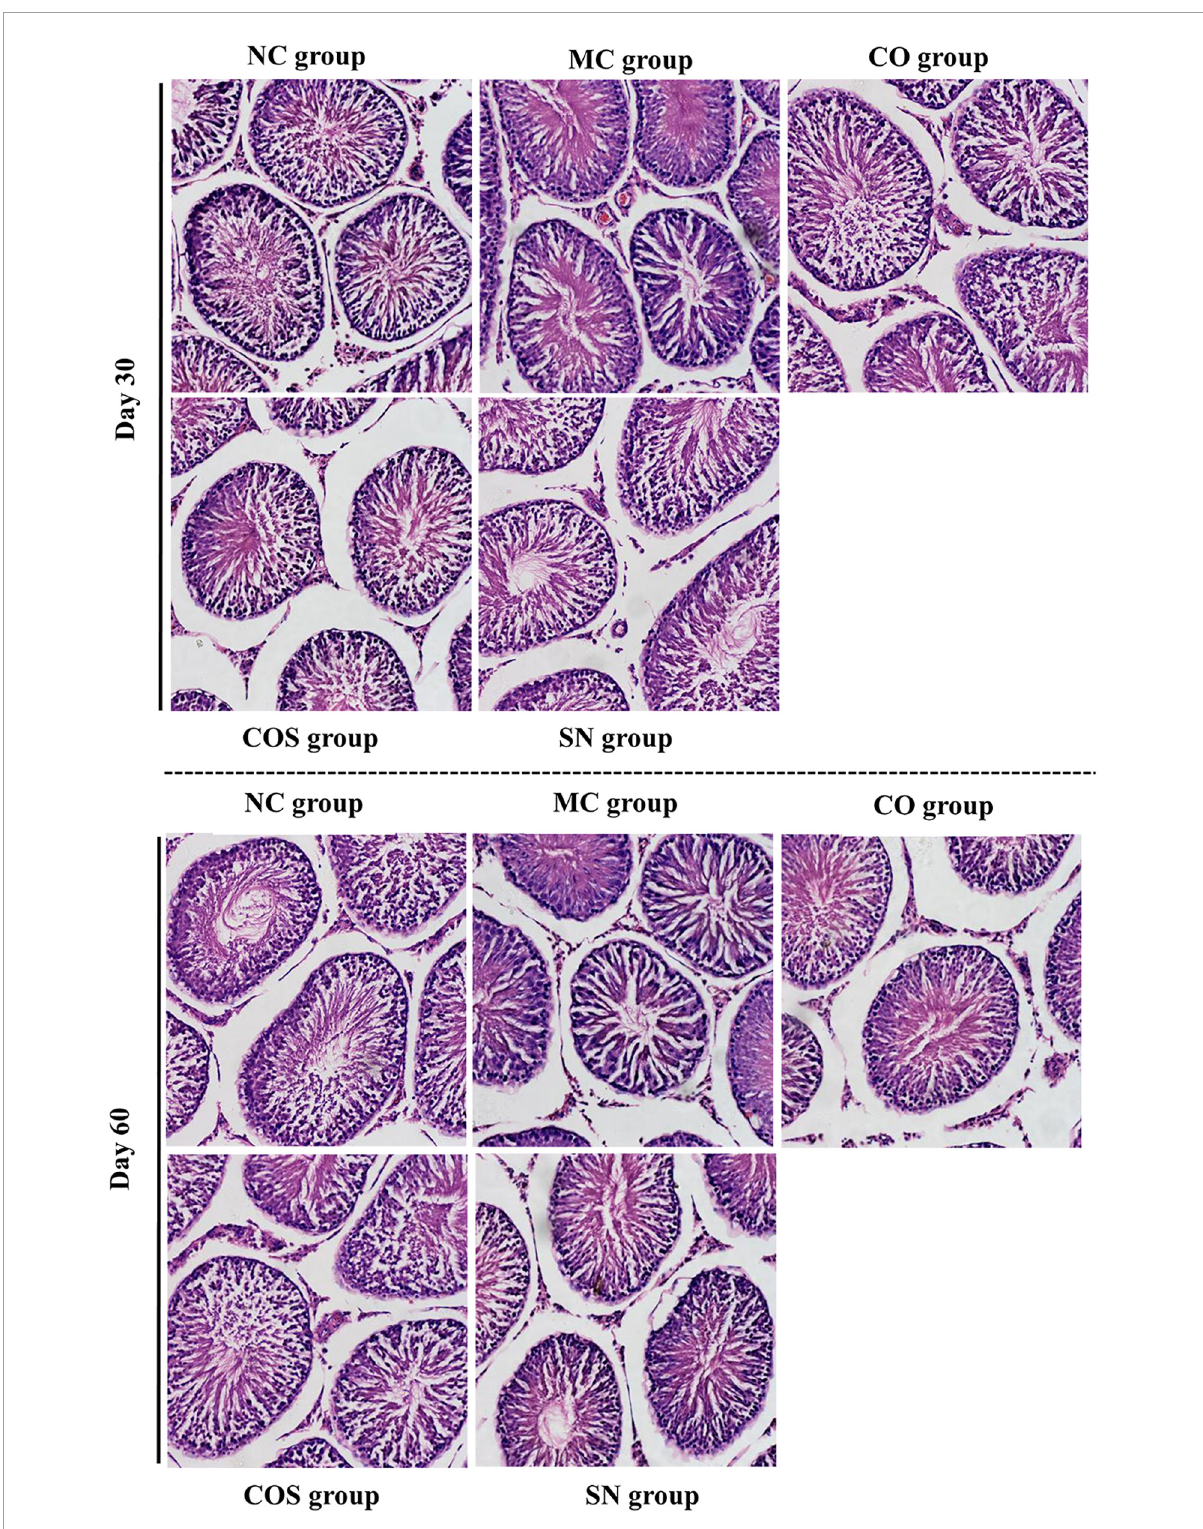
FIGURE6 Testis histomorphologies of hyperlipidemia-induced reproductive damage rats. Photomicrographs of testis tissue sections stained with hematoxylin and eosin (H&E) ( × 200). NC, normal control; MC, model control; CO, Camellia oil; COS, Camellia oil + squalene; SN, sildenafil.